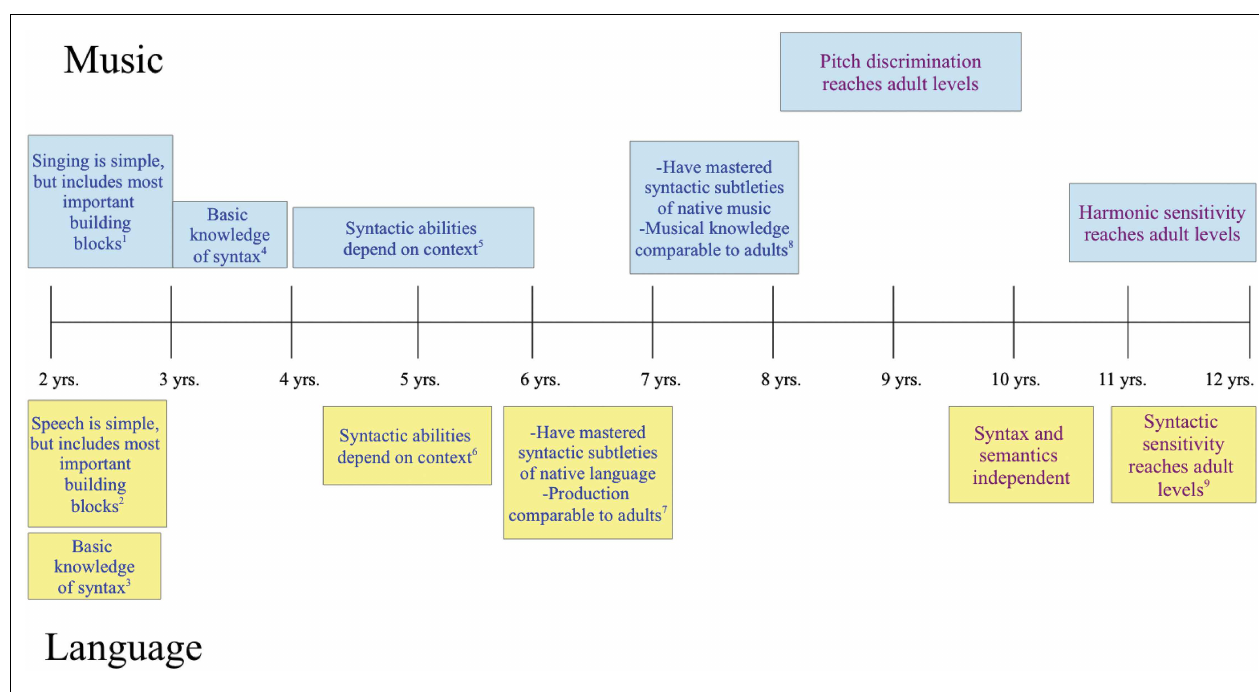
response to unexpected chords (the early right anterior negativity, or ERAN), but do not detect a melodic change that implies a change in harmony. (6) At 5years, processing of function words depends on semantic context and brain activation is not function-specific for semantic v. syntactic processing (unlike adults). (7) Six-year olds are able to speak in complete, well-formed sentences. (8) Seven-year olds have a knowledge of Western tonal structure comparable to adults’ and can detect melodic changes that imply a change in harmony. (9) Only after 10years of age do children show adult-like electrophysiological responses to syntactic errors (Hahne et al.,